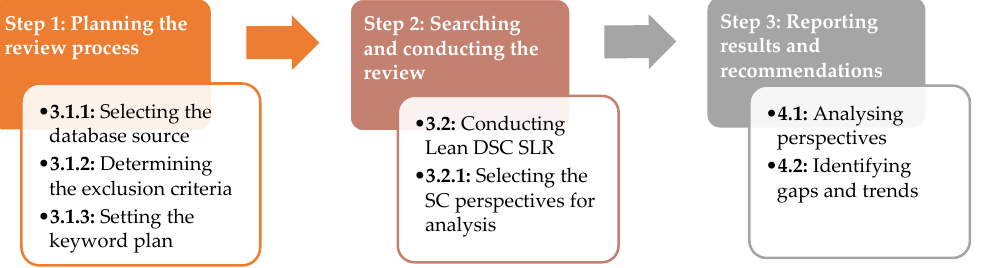
Figure 1. Adopted SLR procedure .